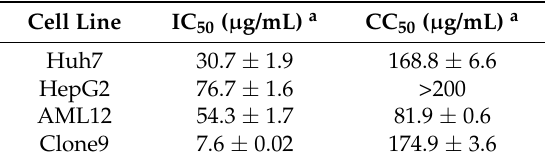
Figure 3. SSLE exerted anti-LD formation activity in other liver cell lines. Three hepatic-lineage cell lines from HepG2 (human), AML12 (mouse), and Clone9 (rat) cells were used to examine the anti-lipid accumulating effect of SSLE by LD assay. Cells were treated as described in Figure 2. Representative images are shown in ( A ) and quantification results in ( B ). Bar: 50 μm . * significant difference from OA control group (** p < 0.01, *** p < 0.001, compared with controls using the one-way ANOVA and Dunnett ’ s tests). Table 2. IC 50 s and CC 50 s of SSLE in liver cell lines.